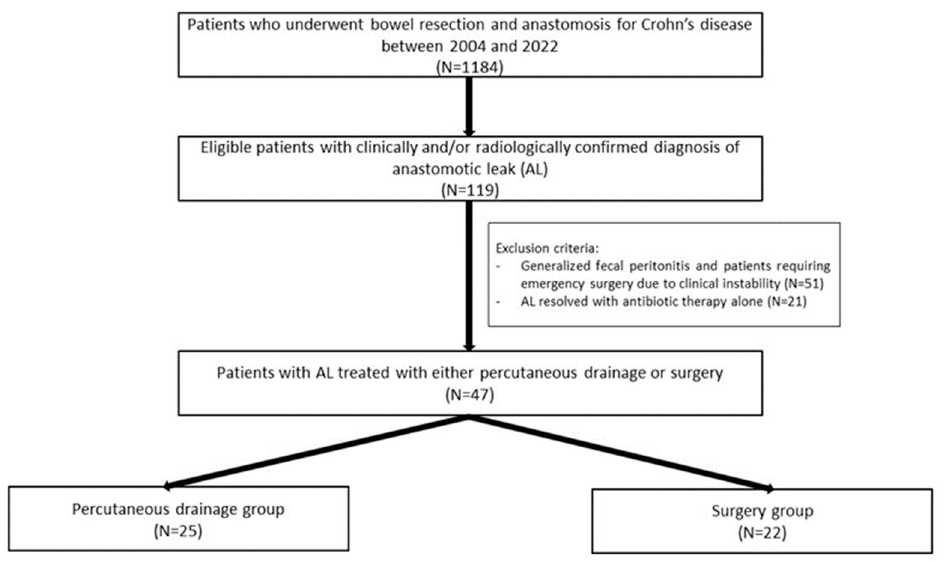
Figure 1. Flow diagram of included patients in the study.